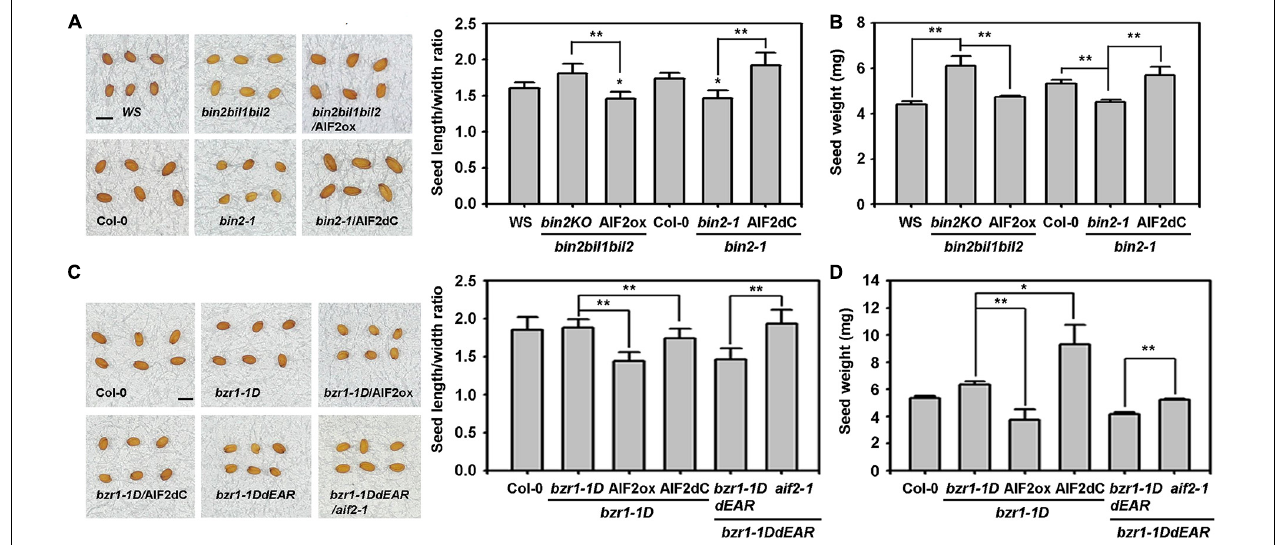
FIGURE 6 | Genetic and functional interactions of AIF2 with BIN2 and BZR1 in the regulation of seed size and weight. (A,B) Evaluation of genetic and functional interaction of AIF2 with BIN2 in the regulation of seed size (A) and seed weight (B) . Transgenic constructs ectopically expressing AIF2ox or AIF2dC were transformed into a BIN2 gain-of-function mutant, bin2-1 , or a BIN2 loss-of-function mutant, bin2bil1bil 2 ( bin2 KO), and their seed phenotypes were evaluated. (C,D) Evaluation of genetic and functional interaction of AIF2 with BZR1 in the regulation of seed size (C) and seed weight (D) . Transgenic constructs ectopically expressing AIF2ox or AIF2dC were transformed into a BZR1 gain-of-function mutant, bzr1-1D , or plants constitutively expressing bzr1-1DdEAR , a loss-of-function form of BZR1, were crossed to aif2-1 to examine their seed phenotypes. Statistical difference between bracketed samples is indicated by an asterisk (*) at P < 0.05 and two asterisks (**) at P < 0.01. Number of seeds examined for measurement of length/width ratio and weight > 800. Scale bars in pictures represent 0.5 mm in length.